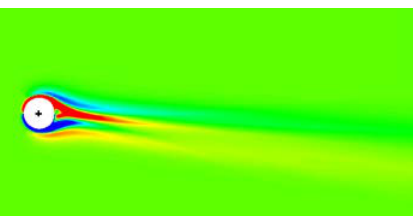
Figure 17. The vorticity of VIV with the Lorentz force (upper surface N = 3, lower surface N = 2) for K = 0.2 .